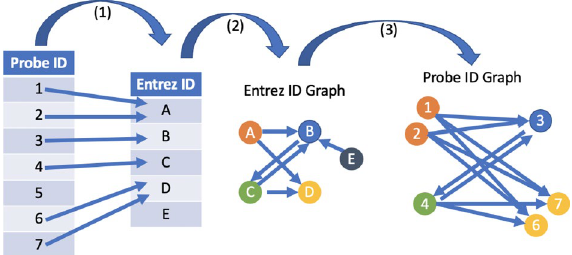
Figure 4. How we generate Probe ID pathway networks using the platform file and Entrez IDs pathway